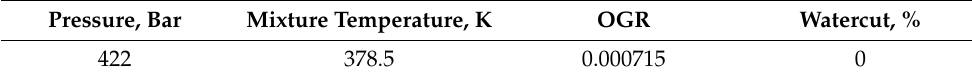
The following table (Table 4) descibe boundary conditions were used for calculation: Table 4. Reservoir